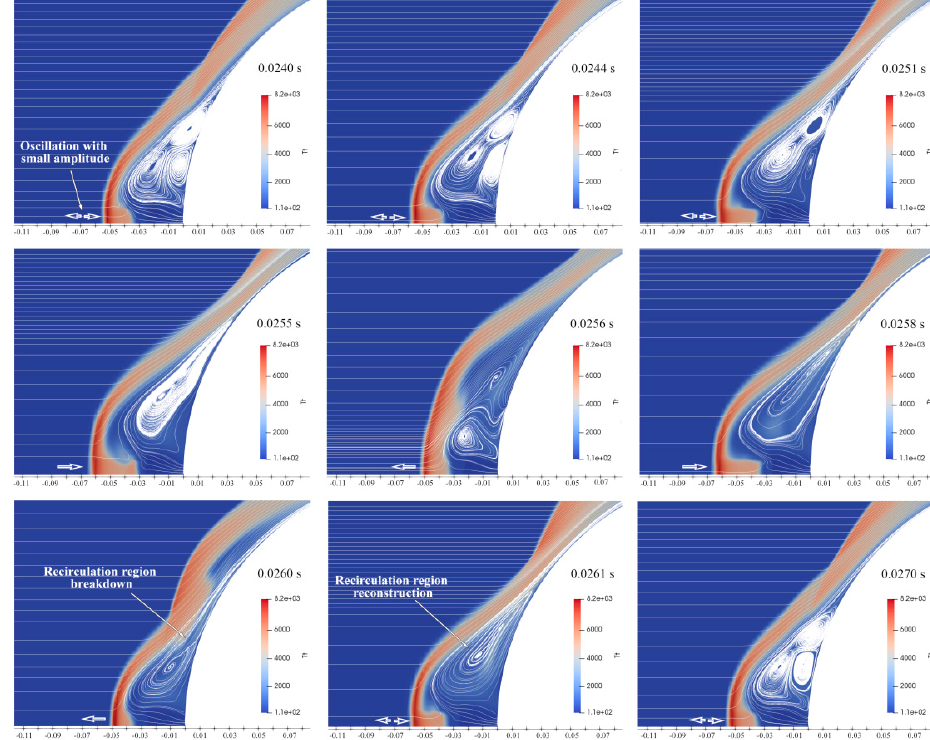
Figure 8. Transient characteristic of